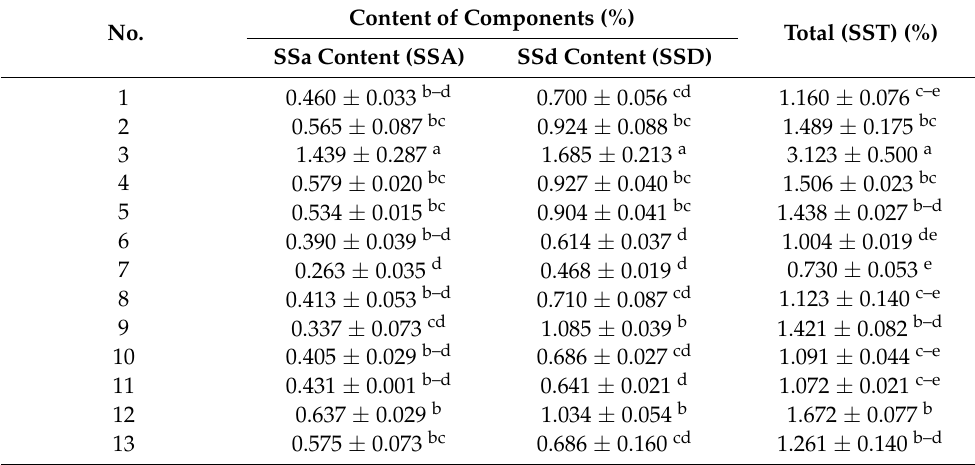
Table 7. Diversity analysis of the content of active ingredients of different Radix bupleuri species.